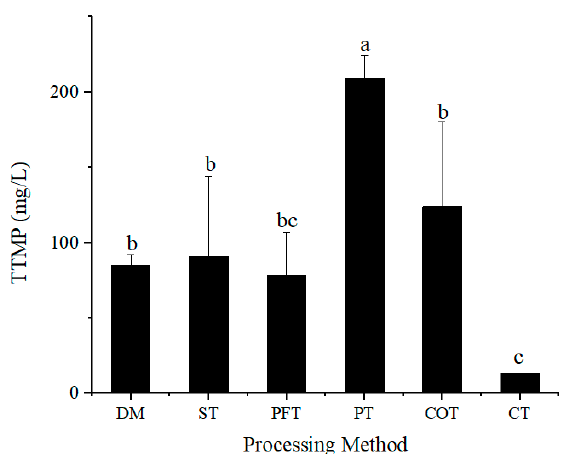
Figure 5. Production of tetramethylpyrazine using molasses with different treatment methods as carbon source. Molasses with different treatment methods (170 mL/L) was added into culture medium. The bar “DM” corresponds to untreated molasses. ST, PT, PFT, COT and CT represent sulfuric acid treatment process, phosphoric acid treatment process, potassium ferrocyanide treatment process, calcium phosphate tribasic treatment process, combinational treatment process, respectively. Data were obtained from triplicate tests and shown as mean ± SD. Bars with a same superscripted letter (a, b or c) mean that there is no statistical